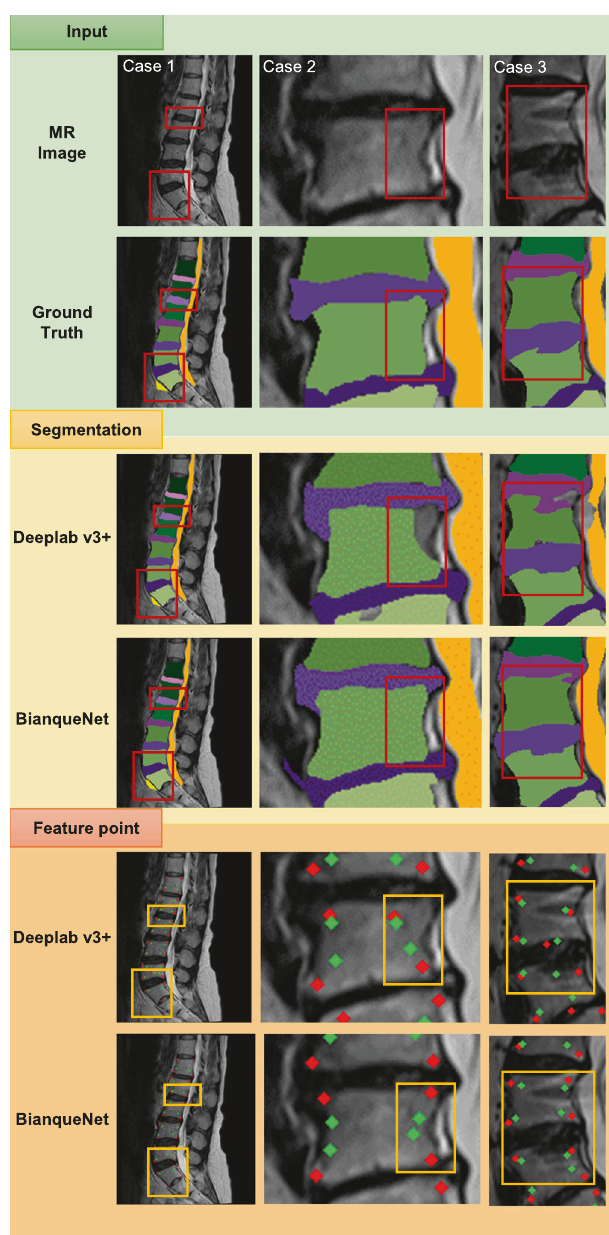
Fig. 2 The segmentation performance of BianqueNet in three typical cases and the in fl uence of different segmentation accuracy on feature- point detection and calculation. Segmentation results in case 1 and case 2 indicate that detailed information on the boundaries of vertebral bodies and IVDs is hard to detect. Segmentation in case 3 shows that irregular boundaries between the IVD and the vertebral bodies may interrupt segmentation with slight structural lesions or imaging defects. Feature- point-extracted results indicate that the precise segmentation may signi fi cantly improve the corner detection on vertebral bodies (red dots), thereby affecting the calculation results of the characteristic points on IVDs (green